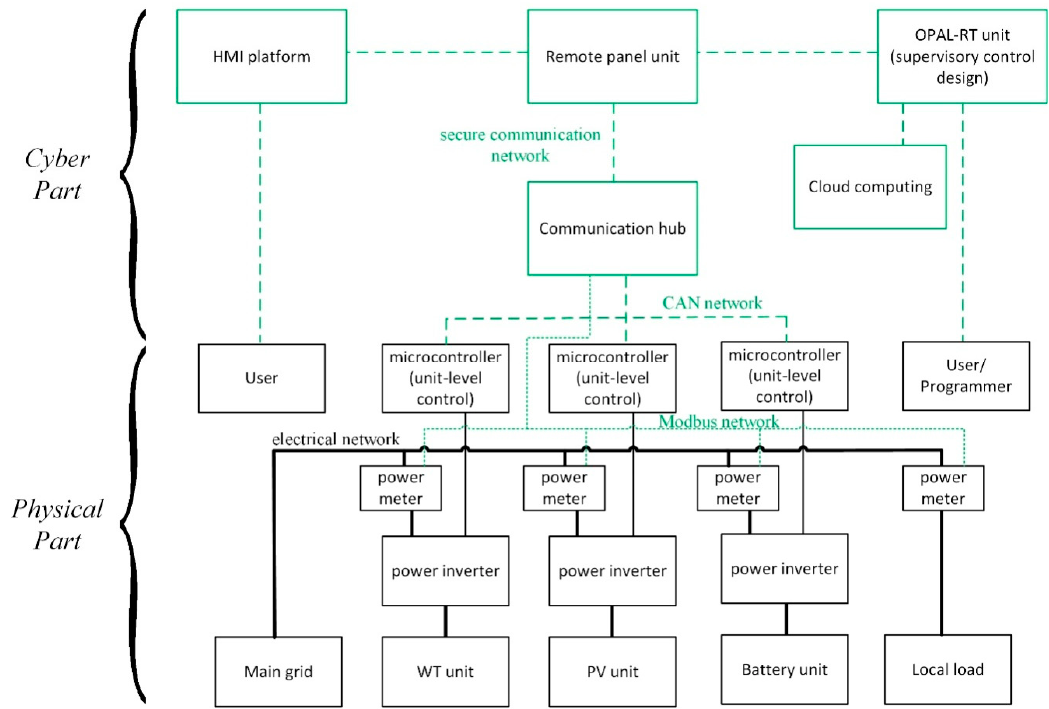
Energies 2020 , 13 , x FOR PEER REVIEW Figure 9. The cyber–physical system (CPS) architecture of the ADEPT system. Figure 9. The cyber–physical system (CPS) architecture of the ADEPT system.